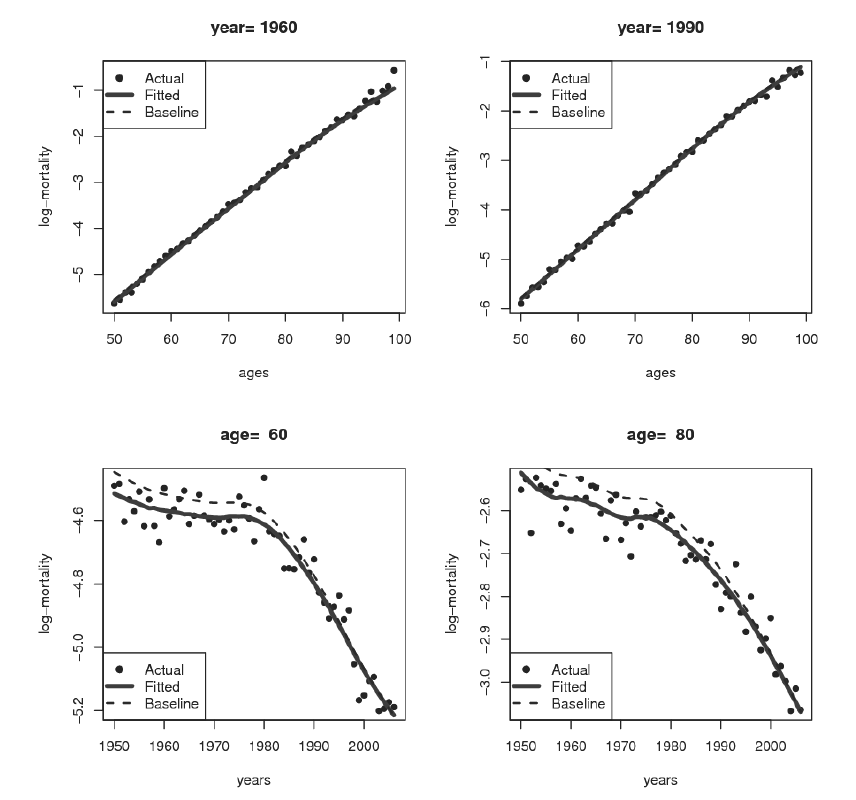
Figura 8 – Observed and fitted mortality rates for selected years and ages. Ip = H and Ic = m 1-4 . Swe- den,